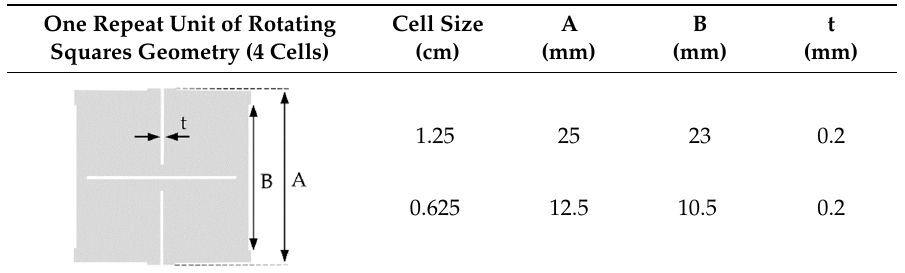
Table 2. Rotating square unit cell geometry.